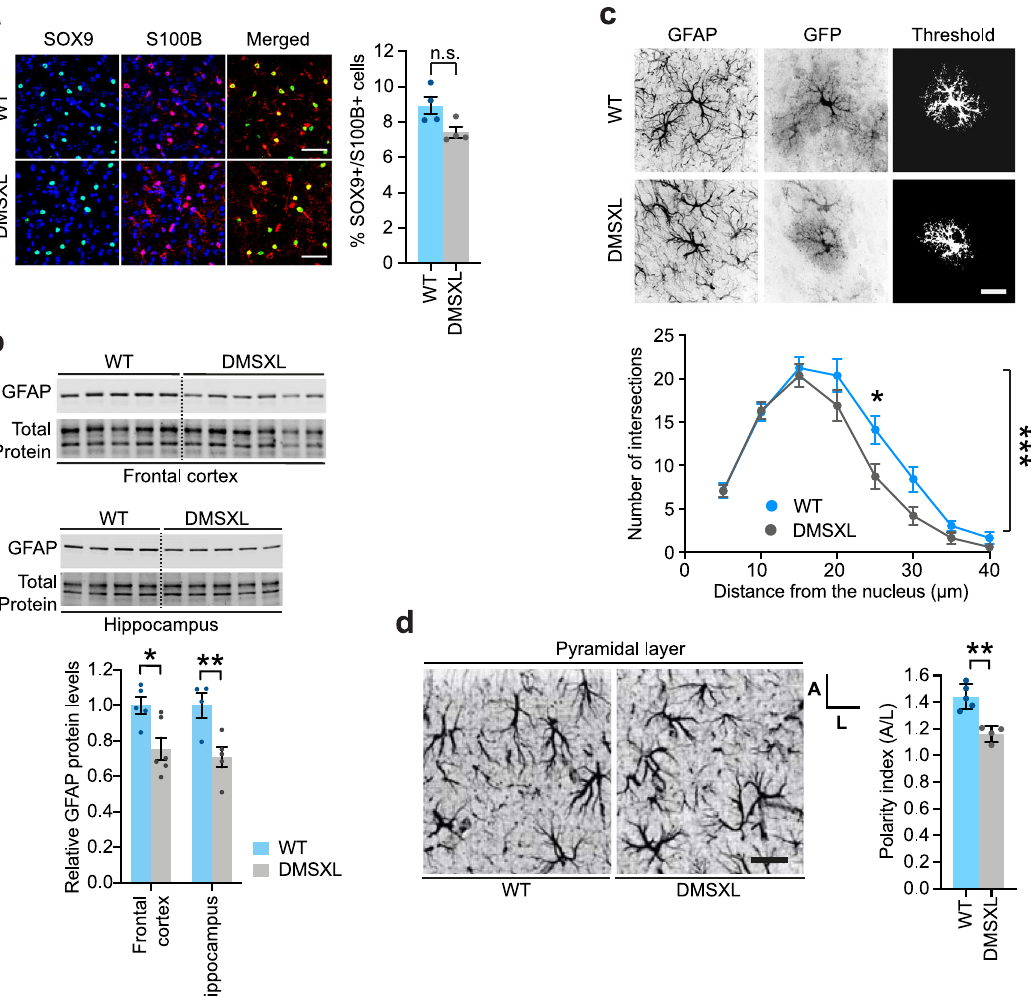
Fig. 1 DMSXL astrocytes show abnormal morphology and polarity in vivo. a SOX9 (green) and S100B (red) immuno fl uorescence in DMSXL frontal cortex at 1 month. Nuclei are stained with DAPI (blue). Scale bar, 50 µ m. Quanti fi cation of double labeled astrocytes. Data are means ± SEM. N = 4